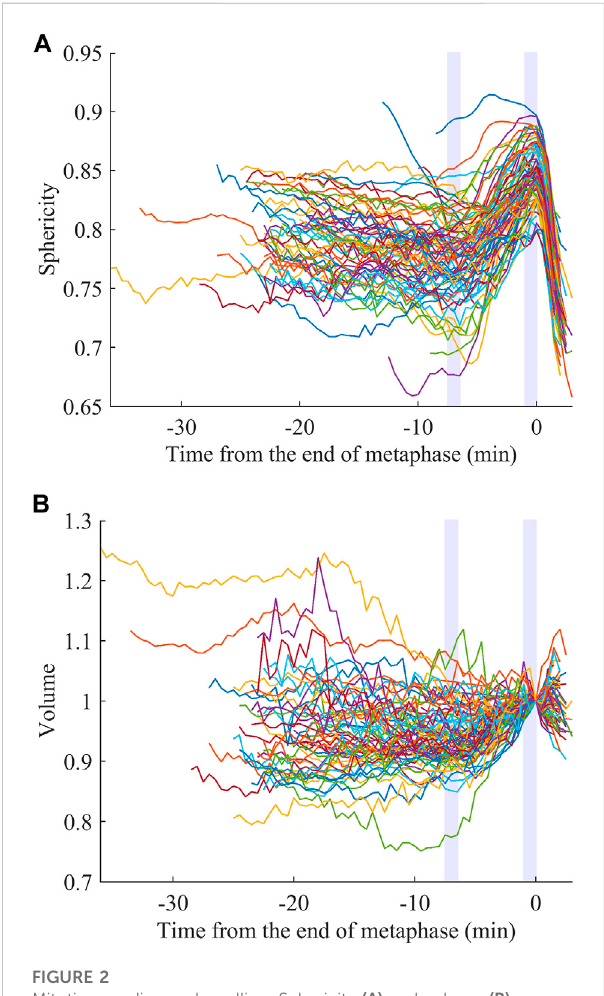
FIGURE 2 Mitotic rounding and swelling. Sphericity (A) and volume (B) dynamics averaged for the 32 embryos registered at the end of metaphase. The light purple rectangles indicate the initial and end of the estimated duration of the mitotic